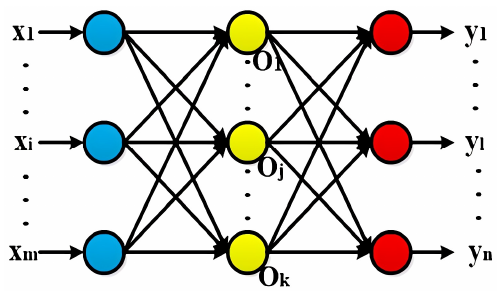
Figure 4. The acoustic decoy deployment scheme.